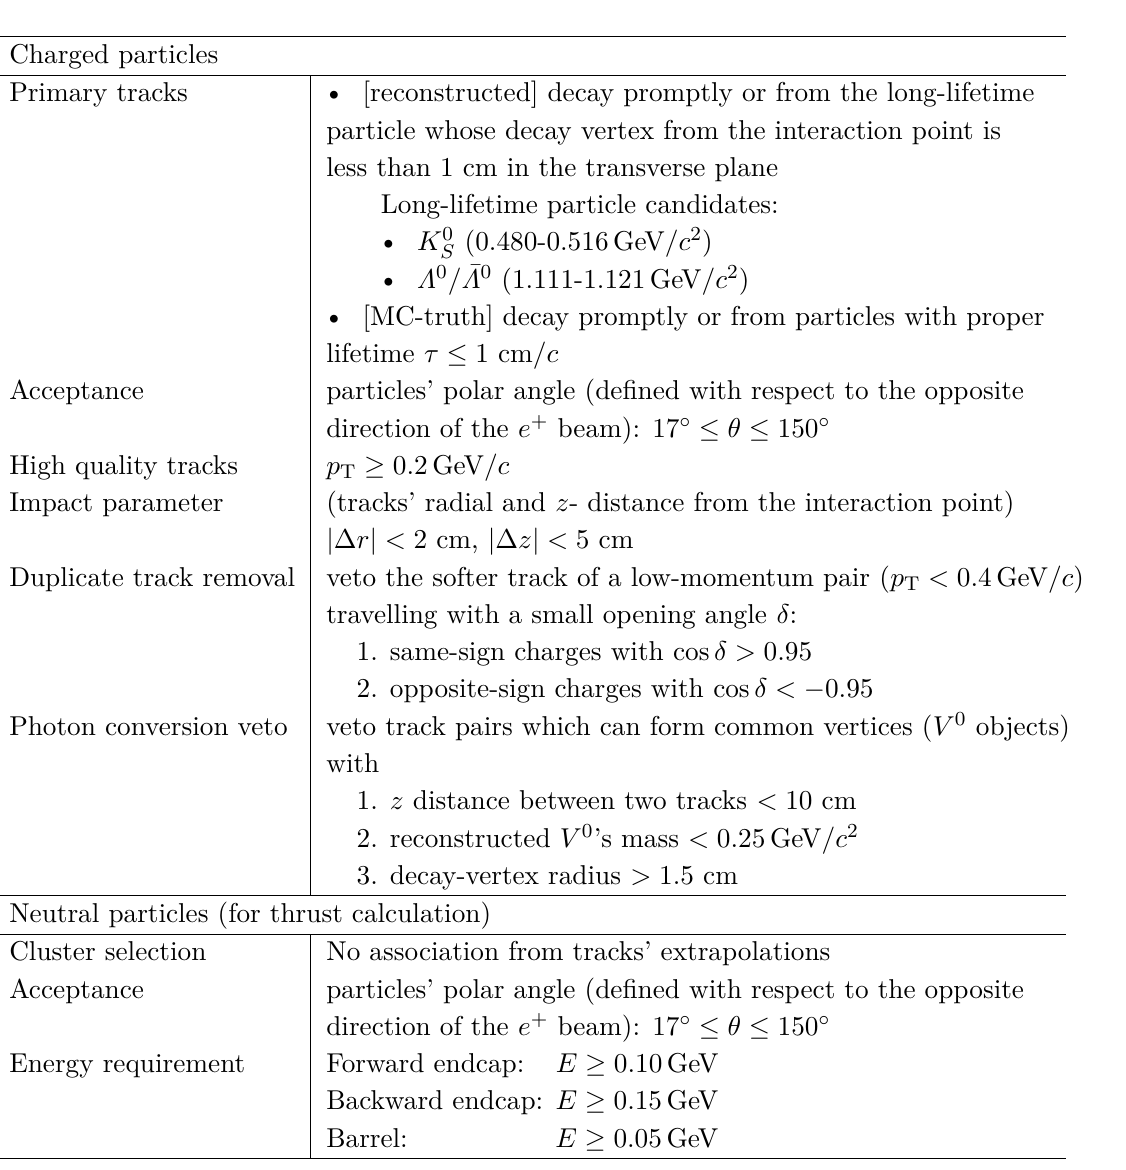
Table 1. Summary table for particle selections. Track selections have been elucidated in ref. [1]. Neutral particles are selected mainly for the event thrust